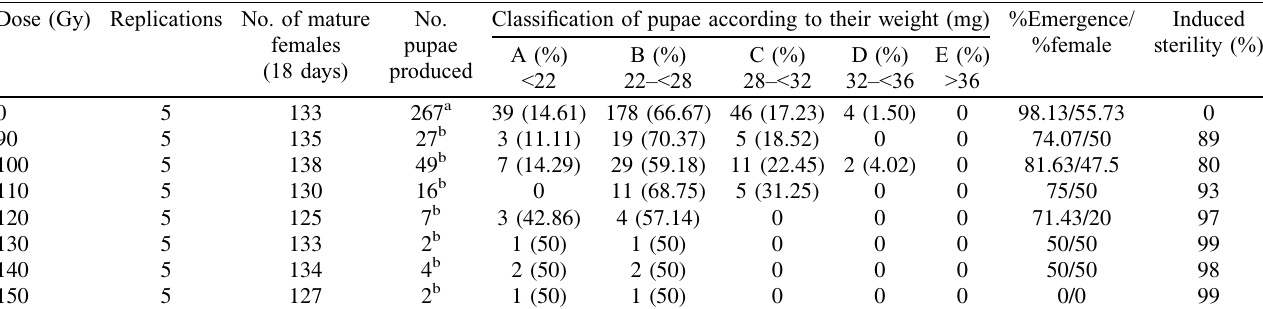
Table 1. Pupal production parameters of G. palpalis gambiensis females mated with males irradiated with different doses after 60 days monitoring.